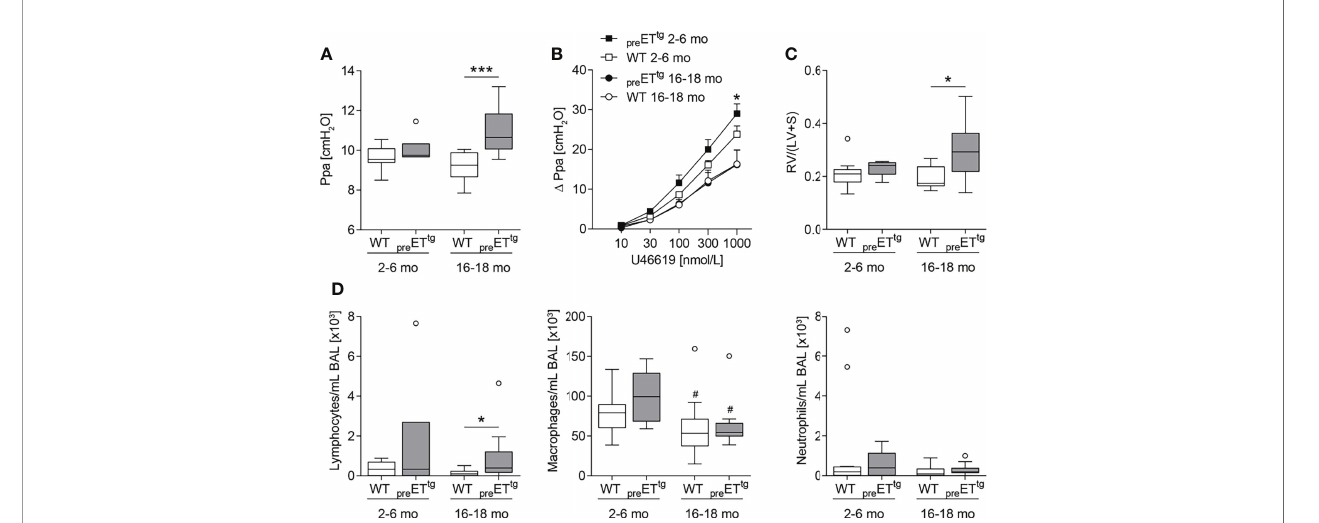
FIGURE 2 | Prepro-endothelin-1 overexpression was age-dependently associated with increased pulmonary arterial pressure, vascular hyperresponsiveness, right ventricular hypertrophy, and increased number of lymphocytes in bronchoalveolar lavage. Lungs and hearts of 2- to 6-month (mo)-old or 16- to 18-mo-old prepro- endothelin-1 overexpressing ( pre ET tg ) mice and corresponding wild-type (WT) mice were prepared, or bronchoalveolar lavage (BAL) was performed. (A) In isolated perfused and ventilated lungs, under basal conditions, 16- to 18-mo-old pre ET tg showed a higher pulmonary arterial pressure (Ppa) compared to WT mice of the same age. (B) Pulmonary vascular responsiveness to intravascular application of the thromboxane receptor agonist U46619 was increased in 2- to 6-mo-old pre ET tg mice compared to WT controls of the same age. Data ( D Ppa) represent the difference between the highest pressure response to U46619 and the basal Ppa. (C) Fulton index [quotient of right ventricle (RV) and left ventricle (LV) including septum (S)] determined after weighing the cardiac compartments was higher in 16- to 18-mo-old pre ET tg compared to WT mice of the same age. (D) Analysis of differentially quanti fi ed leukocytes in BAL showed increased number of lymphocytes in 16- to 18-mo-old pre ET tg compared to WT mice of the same age, whereas macrophages decreased with age, independent of prepro-ET-1 overexpression. In (A, C, D), data are represented as box plots depicting median, quartiles, and ranges excluding outliers ( open circles ), and analyzed using Mann – Whitney U test. # indicates signi fi cant difference between 16- to 18-mo-old vs. 2- to 6-mo-old groups, * indicates signi fi cant difference between pre ET tg vs. corresponding WT group (as indicated). In (B) , values are given as mean and SEM, and analyzed using two-way repeated measures ANOVA, followed by a single Mann – Whitney U test between values of pre ET tg and WT mice of the same age at the highest dose of U46619 (*). In (A – C) , N = 5 – 12; in (D) , N = 7 – 17. * /# p < 0.05, *** p <